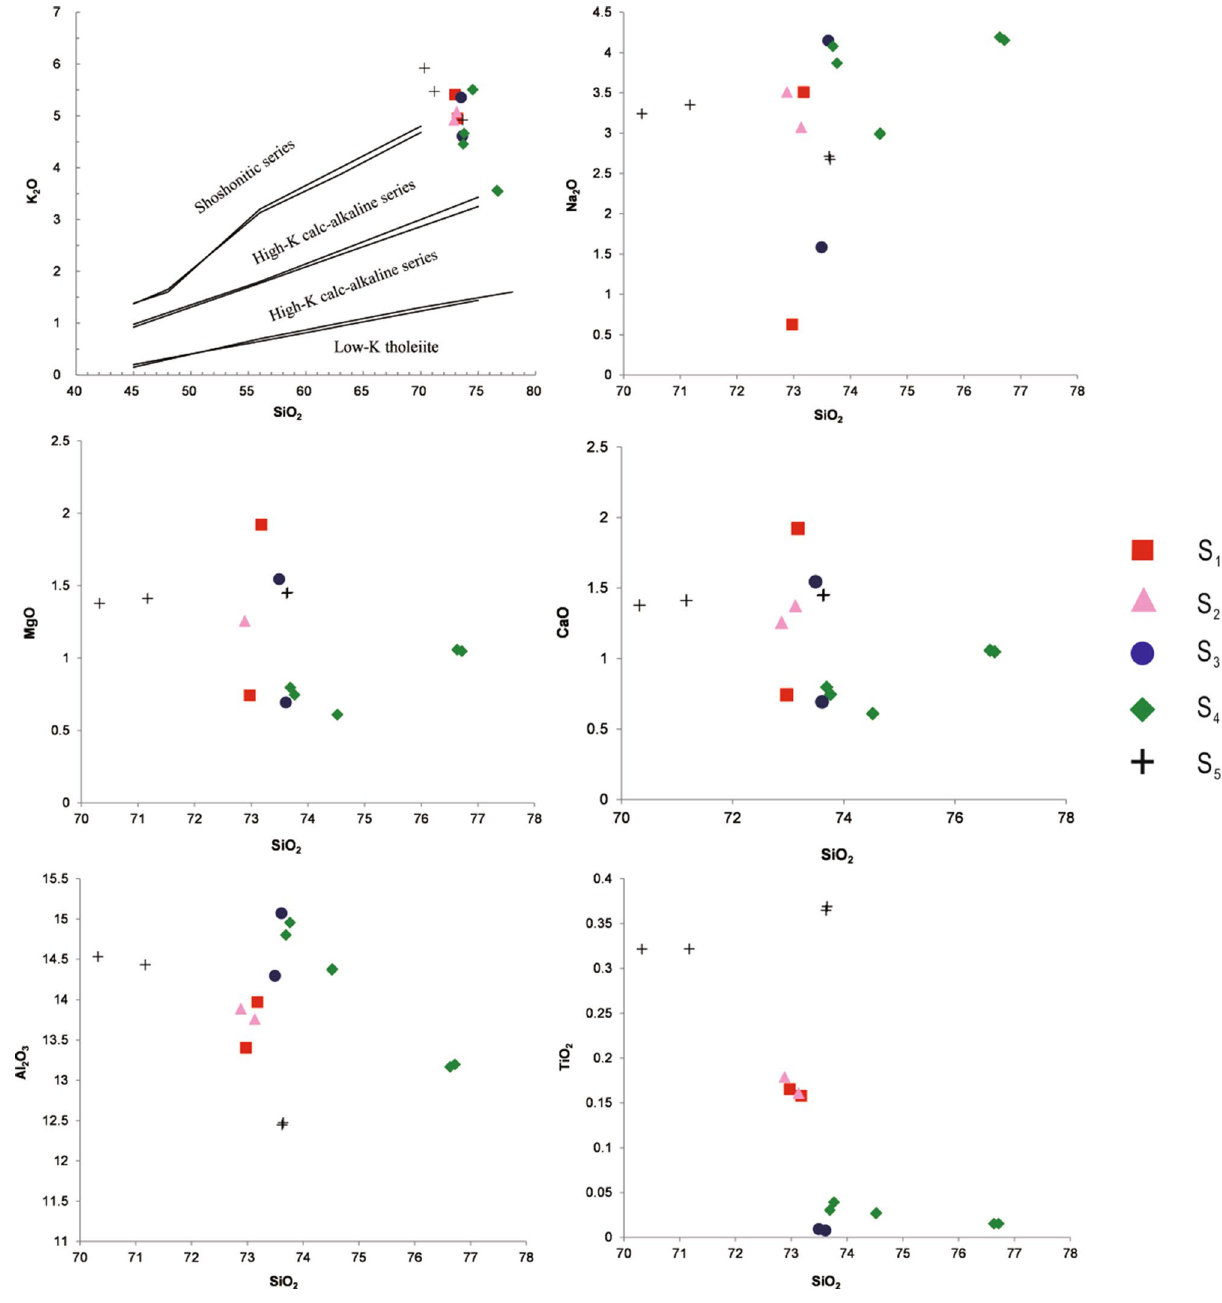
Figure 7. Harker diagram for the